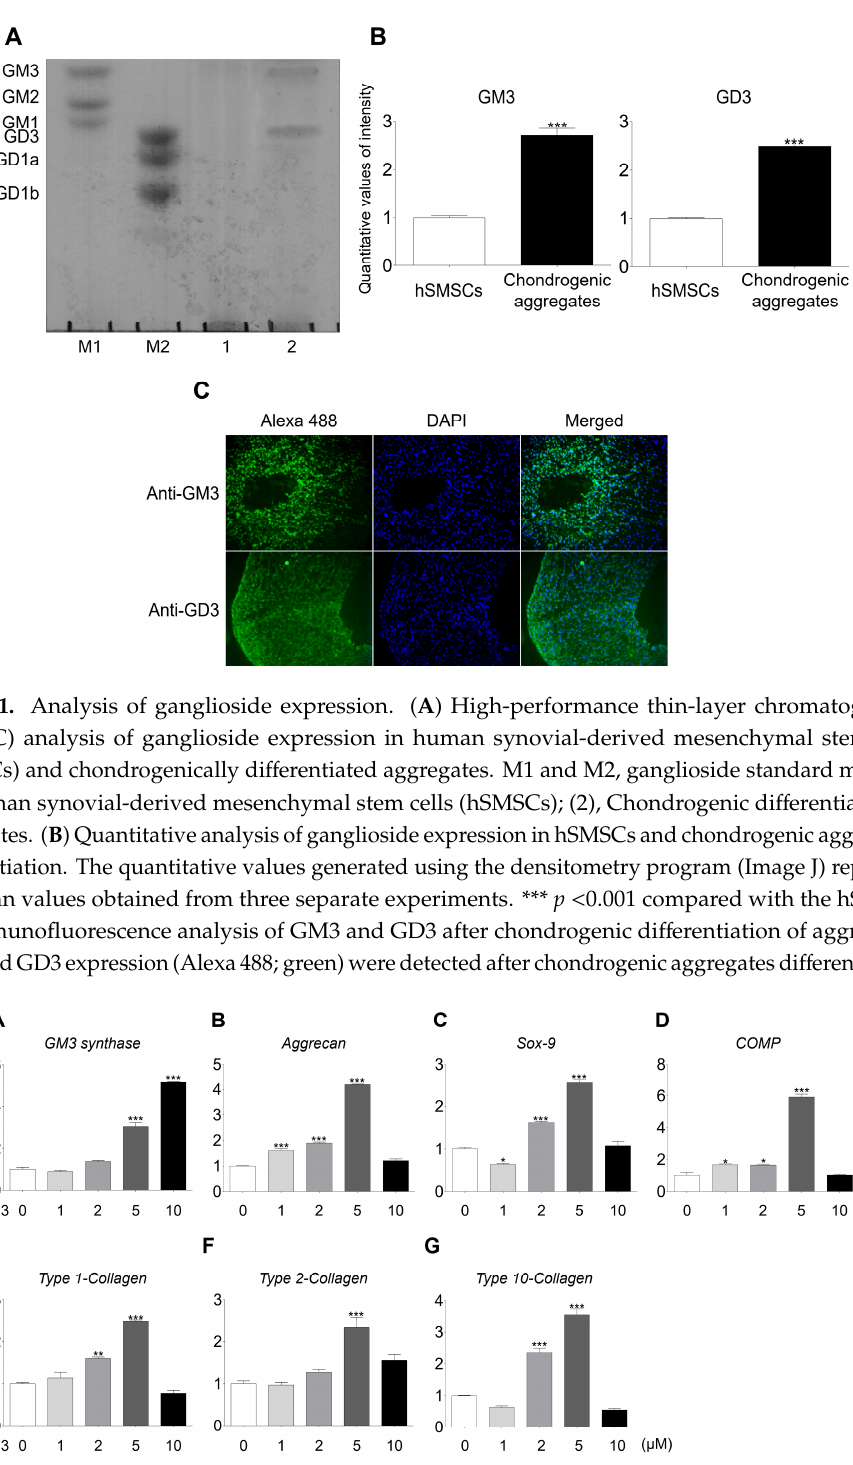
Figure 2. Comparison of chondrogenic specific markers expression after the chondrogenic differentiation of aggregates. GM3 (0, 1, 2, 5, and 10 μ M) was used for treatment during the chondrogenic differentiation of hSMSC aggregates. ( A ) GM3 synthase, ( B ) aggrecan, ( C ) SOX-9, ( D ) cartilage oligomeric matrix protein (COMP) , ( E ) type 1-Collagen , ( F ) type 2-collagen , and ( G ) type 10-collagen expression were compared by qPCR. mRNA expression levels were normalized to the housekeeping gene β -actin. The values shown are the mean ± SEM from three independent experiments. * p < 0.05, ** p < 0.01 and *** p < 0.001 compared with the 0 μ M GM3 treated group. After chondrogenic differentiation, the hSMSC aggregates were stained with toluidine blue (for matrix proteoglycans), safranin O (for cartilage), and hematoxylin and eosin (Figure 3A–C). The 5 μ M GM3 treated group had significantly increased toluidine blue (1.85 ± 0.18 folds, Figure 3A,B) and safranin O (1.80 ± 0.08 folds, Figure 3A,C) staining compared with the 0 μ M treated group. Moreover, accumulation of GAG/DNA significantly increased in the 5 μ M GM3 treated group compared with that in the 0 μ M treated group (5 μ M GM3 treated group, 16.48 ± 1.45 μ g/ μ g; 0 μ M GM3 treated group, 3.69 ± 0.12 μ g/ μ g). Therefore, our results suggested that GM3, specifically 5 μ M GM3, improved the chondrogenic differentiation of hSMSC aggregates.